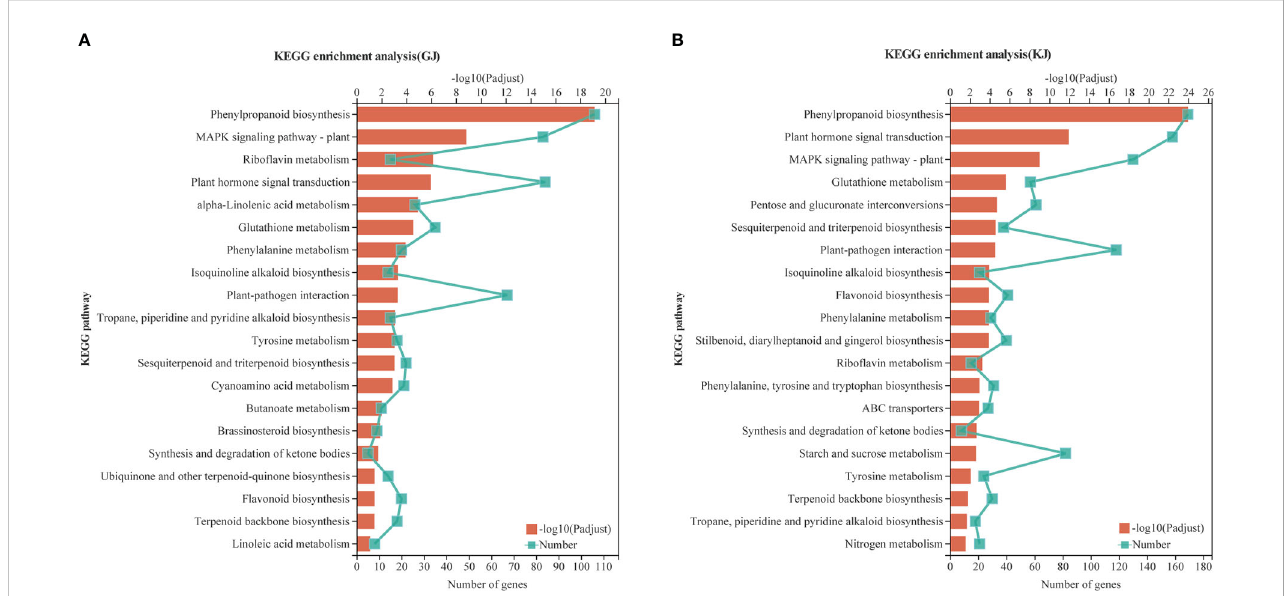
FIGURE 5 Enrichment analysis of KEGG pathway of GJ and KJ overdominant expression genes. (A) KEGG analysis of overdominant up-regulated and down- regulated genes in GJ hybrids. (B) KEGG analysis of overdominant up-regulated and down-regulated genes in KJ hybrids.